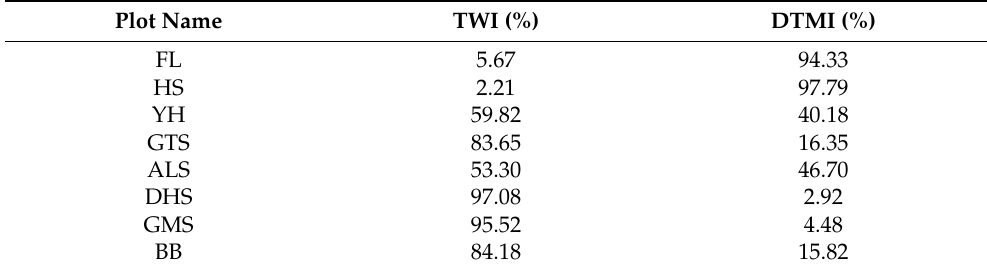
Table A3. Relative importance results of the spatial simultaneous autoregressive error models